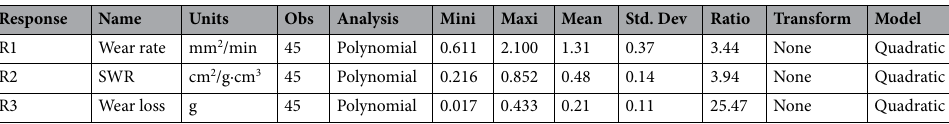
Table 4. Design build information for the response